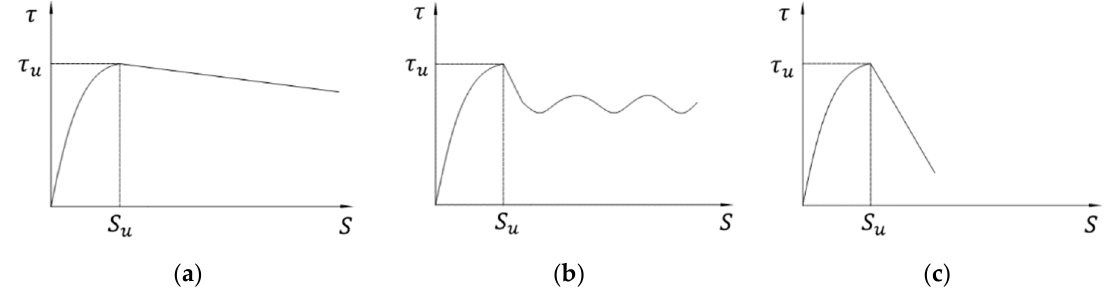
Figure 13. Typical bond-slip curves: ( a ) regular bar and double-wrapped bar subject to bar pull-out failure; ( b ) ribbed bar subject to bar pull-out failure; ( c ) regular bar and double-wrapped bar subject to concrete splitting failure.